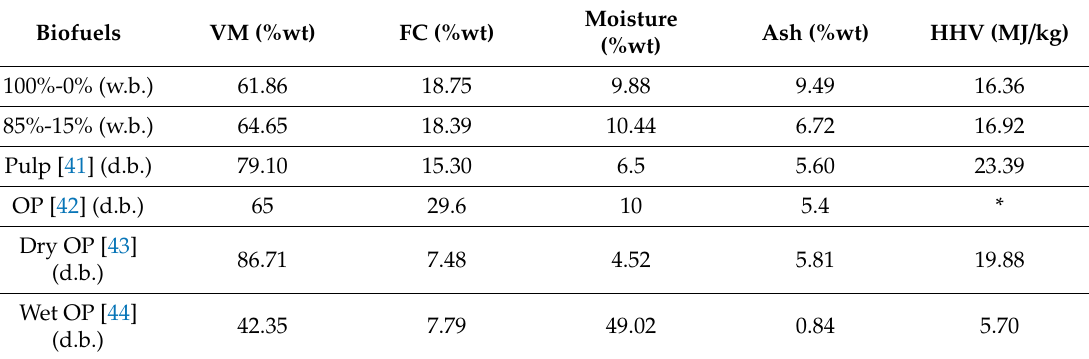
Table 3. Proximate analysis of prepared samples and others from